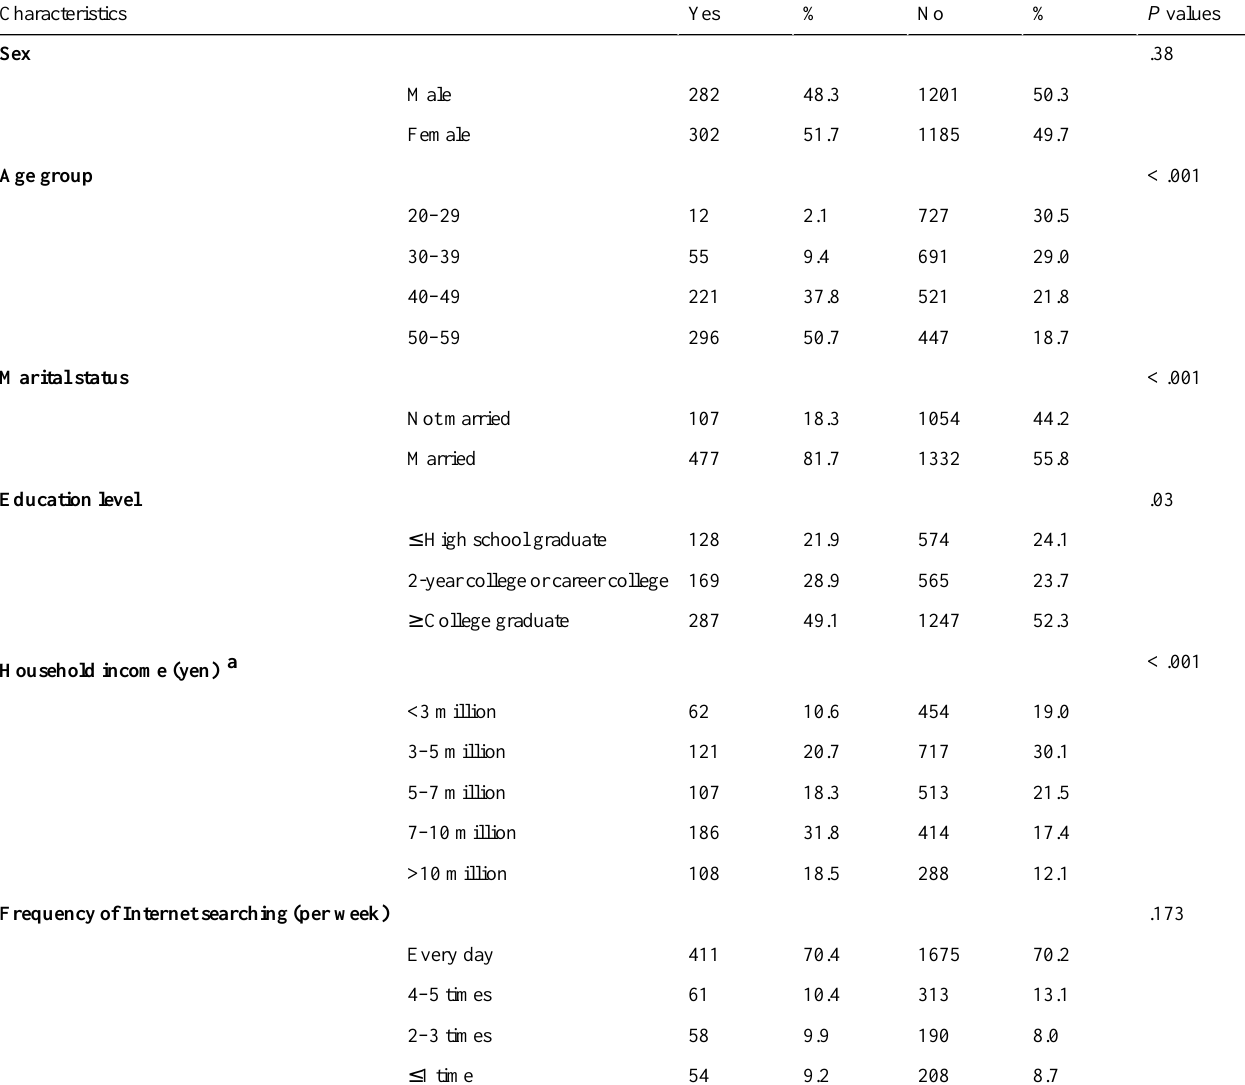
Table 5. Association of CRC screening practice with sociodemographic characteristics and frequency of Internet